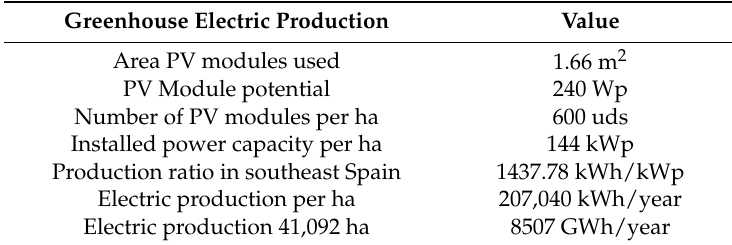
Table 4. Energy production estimation for a 10% greenhouse area covered by PV modules (Authors’ calculation).